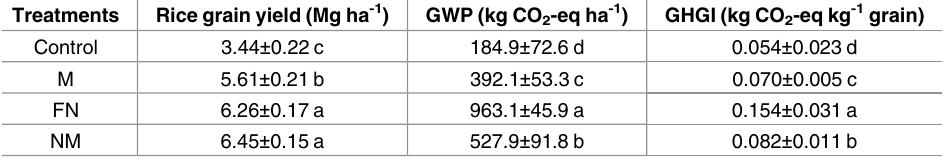
Data are means ± standard error (n = 3). Different letters within the same column indicate significant differences among treatments at P <